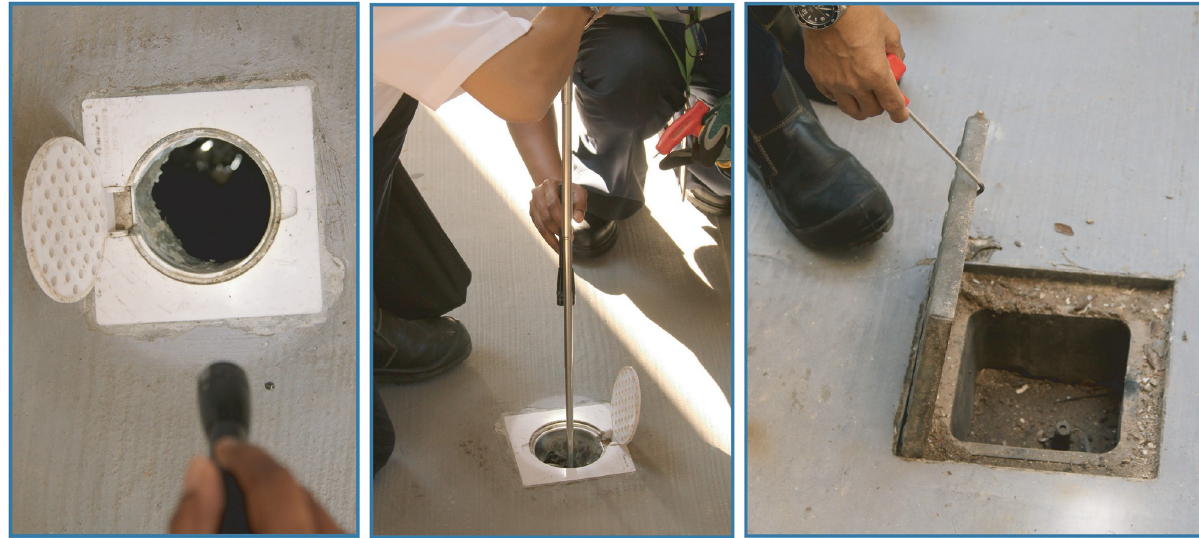
Fig 8. House inspections by NEA officers to identify Aedes habitats. NEA, National Environment